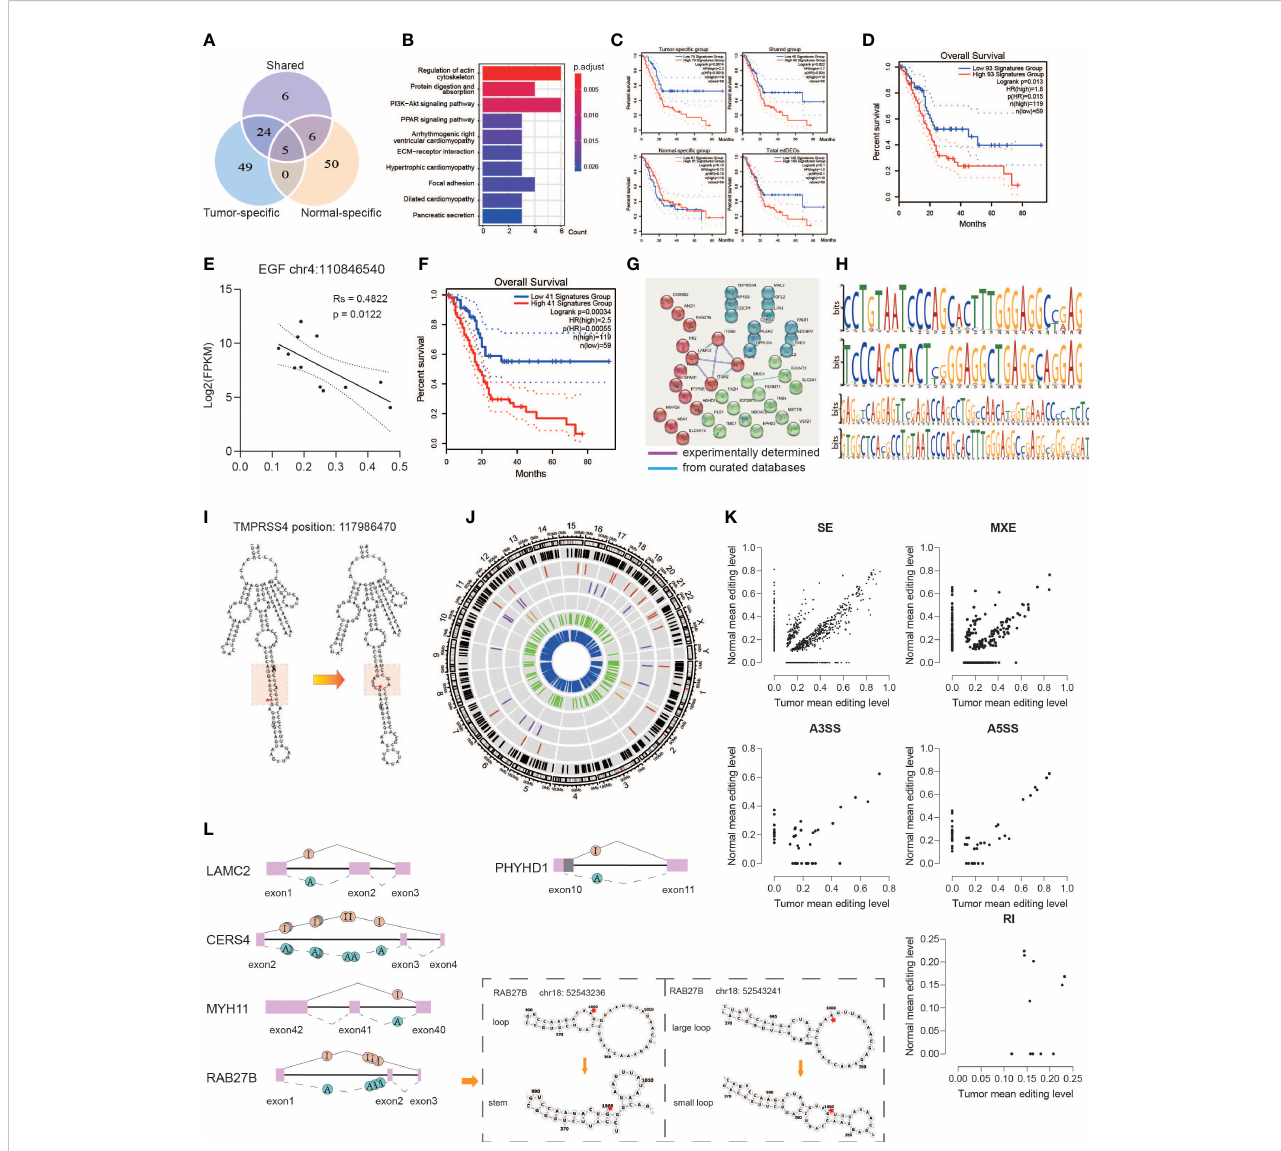
FIGURE 5 Functional alteration of A-to-I DREs. (A) Editing sites located in the 140 edDEGs coexisting in genes with DREs and DEGs among three groups. (B) KEGG pathway enrichment for overlapped genes. (C) Correlation analysis with overall survivals based on edDEGs in the tumor-speci fi c group, shared group, and normal-speci fi c group and in general. (D) Correlation analysis with overall survivals based on 93 overlapped genes matching with the expression status in GEPIA2. (E) A representative RNA editing site displaying the signi fi cant correlation between RNA editing level and RNA expression. (F) Correlation analysis with overall survivals based on 41 edDEGs signi fi cantly associated with prognosis in TCGA-PAAD dataset. (G) PPI shows two important interactions among overlapped genes. (H) Motif analysis by MEME showing a preference in GA/CA enrichment. (I) Representative change of RNA secondary structure in the GA enrichment region due to A-to-I RNA editing at position 117986470 in TMPRSS4. Red star indicates the editing site. Red region represents the GA-rich region. (J) Circos diagram displaying the distribution of sDREs in chromosomes. The black line represents total sDRE distribution, and the red, purple, brown, green, and blue lines represent sDREs belonging to A3SS, A5SS, RI, MXE, and SE. (K) Scatter diagrams showing the editing level of sDREs among each alternative splicing event. (L) Representative alternative splicing events displaying RNA editing events that altered the RNA secondary